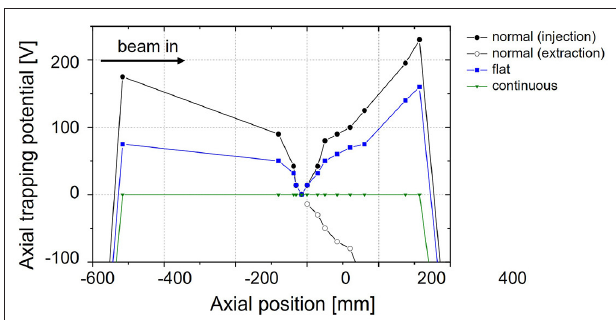
FIGURE 7 | Different configurations of the axial trapping potential in REXTRAP. In the normal trapping configuration, the beam enters from the left side several 10eV above the barrier or approximately 200eV above the central trapping electrode (95).